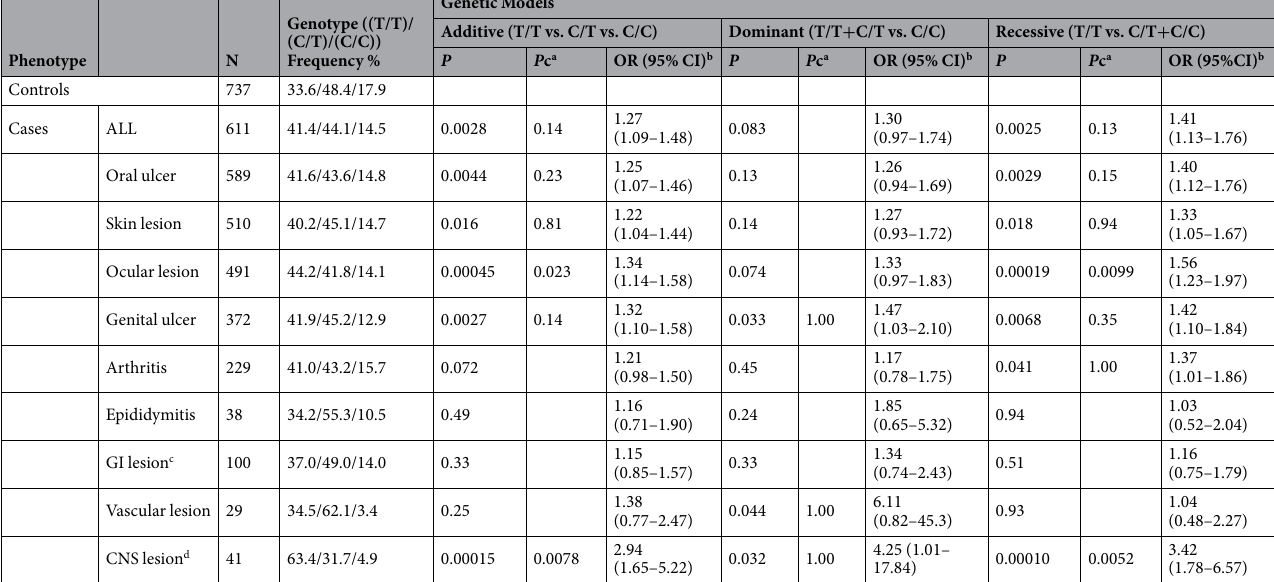
Table 3. Genotypic association results between rs9517723 and clinical symptoms of Behçet’s disease. a P c,